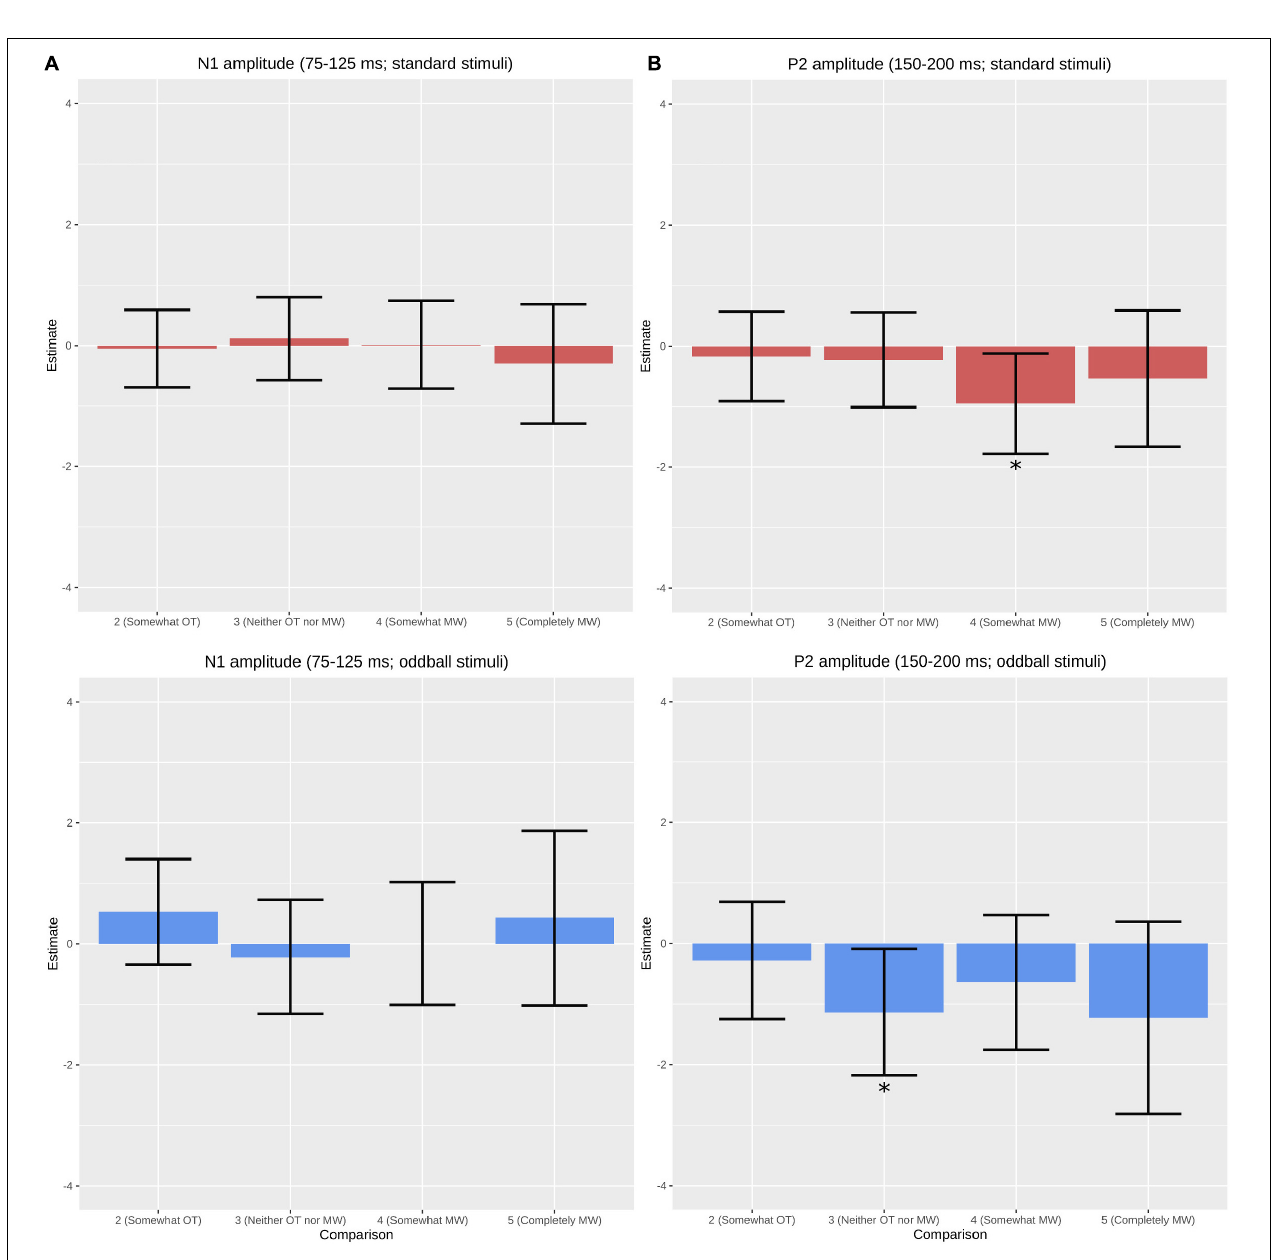
FIGURE 2 | Comparisons of event-related potential estimates from linear mixed effects analysis using the “completely on task” state as the reference variable. (A) Responses to standard stimuli at the 75–125 ms window were not significantly different during the various reported mind wandering states, though responses to oddball stimuli were significantly lower. (B) Responses to standard stimuli at the 150–200 ms windows were consistently lower, though only significantly so during the “somewhat mind wandering” state. *Denotes significant at α =